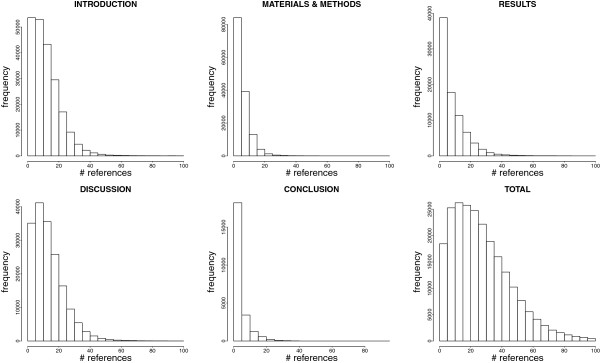
Cited references distributions. Data from the open access subset of PubMed Central shows that the distribution of cited references varies between full documents (Total) and across sections. The y-axis shows the number of PMC-OA documents.